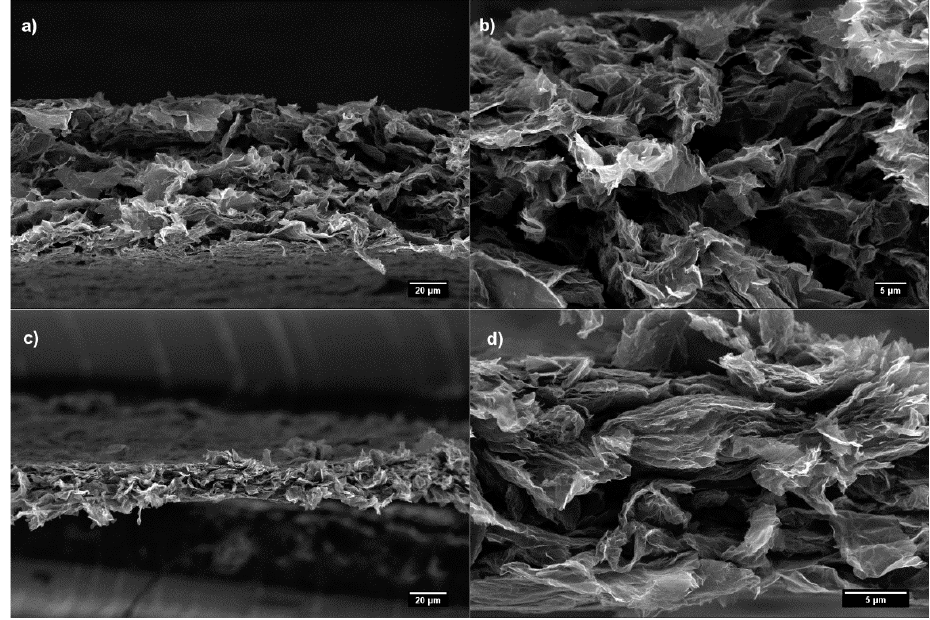
Figure 2. Cross-sectional FESEM images of ( a ) RGO nanopaper and ( c ) RGO_1700 nanopaper and corresponding higher magnifications ( b , d ), respectively.